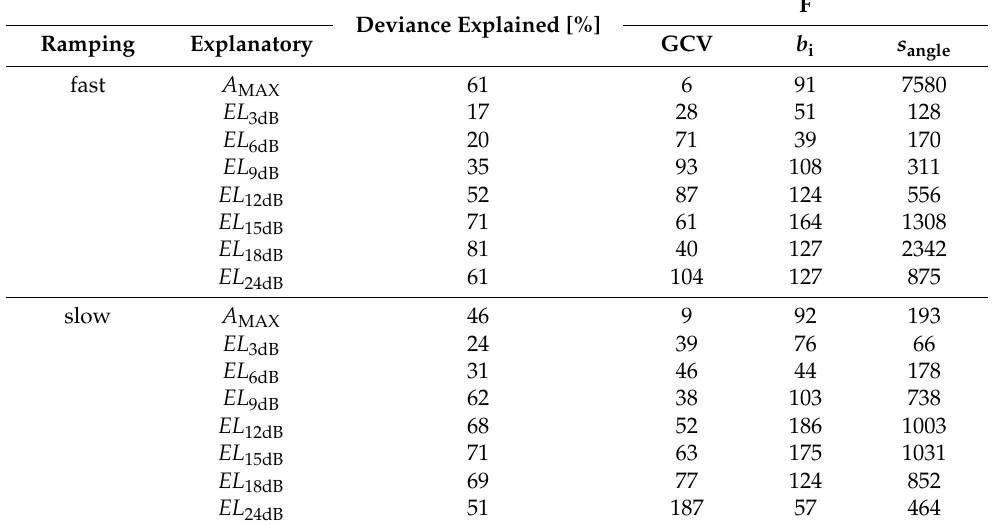
Table 3. Results of the generalized additive mixed model M2 for the amplitude maximum ( A MAX ) and echo lengths ( EL ) at several levels assessing their explained deviance, generalized cross-validation cri- terion (GCV), and variation (F = F statistic) in their components of b i (effective degrees of freedom = 5, p -value = <2 × 10 − 16 ) and s angle (effective degrees of freedom = 7, p -value = <2 × 10 − 16 ) for fast (n = 5928) and slow ramping (n =